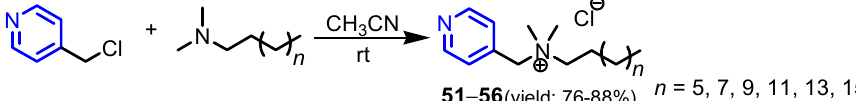
Scheme 10. Synthesis of pyridine salts 51 − 56 [31]. Table 2. Antimicrobial activities of compounds 51 − 56 expressed as MIC values (mM) [31]. Compound